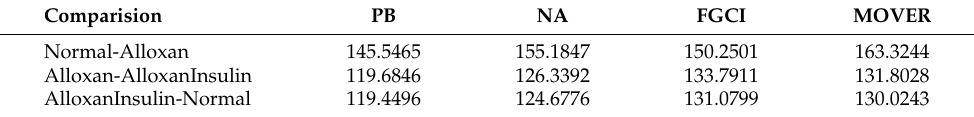
Table 10. The lengths of 95% confidence intervals for the differences of the medians for 3